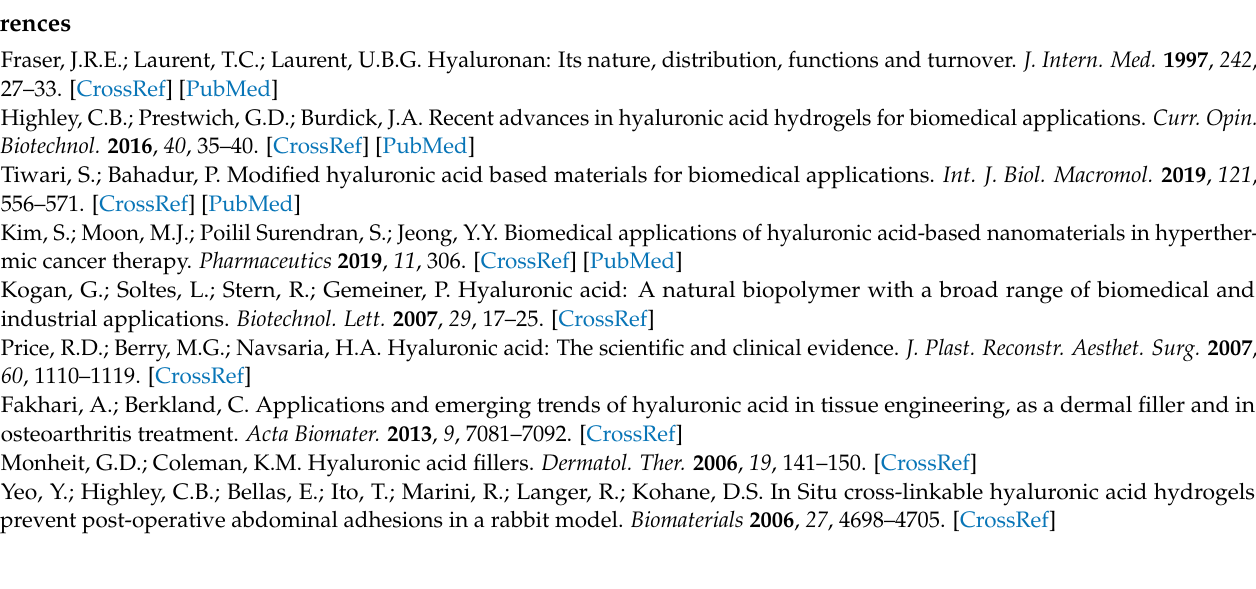
Figure 7. Schematic illustration of mesenchymal HA-mimicking HA–catechol platform for salivary gland tissue engineering. Re- printed with permission from [44]. Copyright © 2020 American Chemical Society.